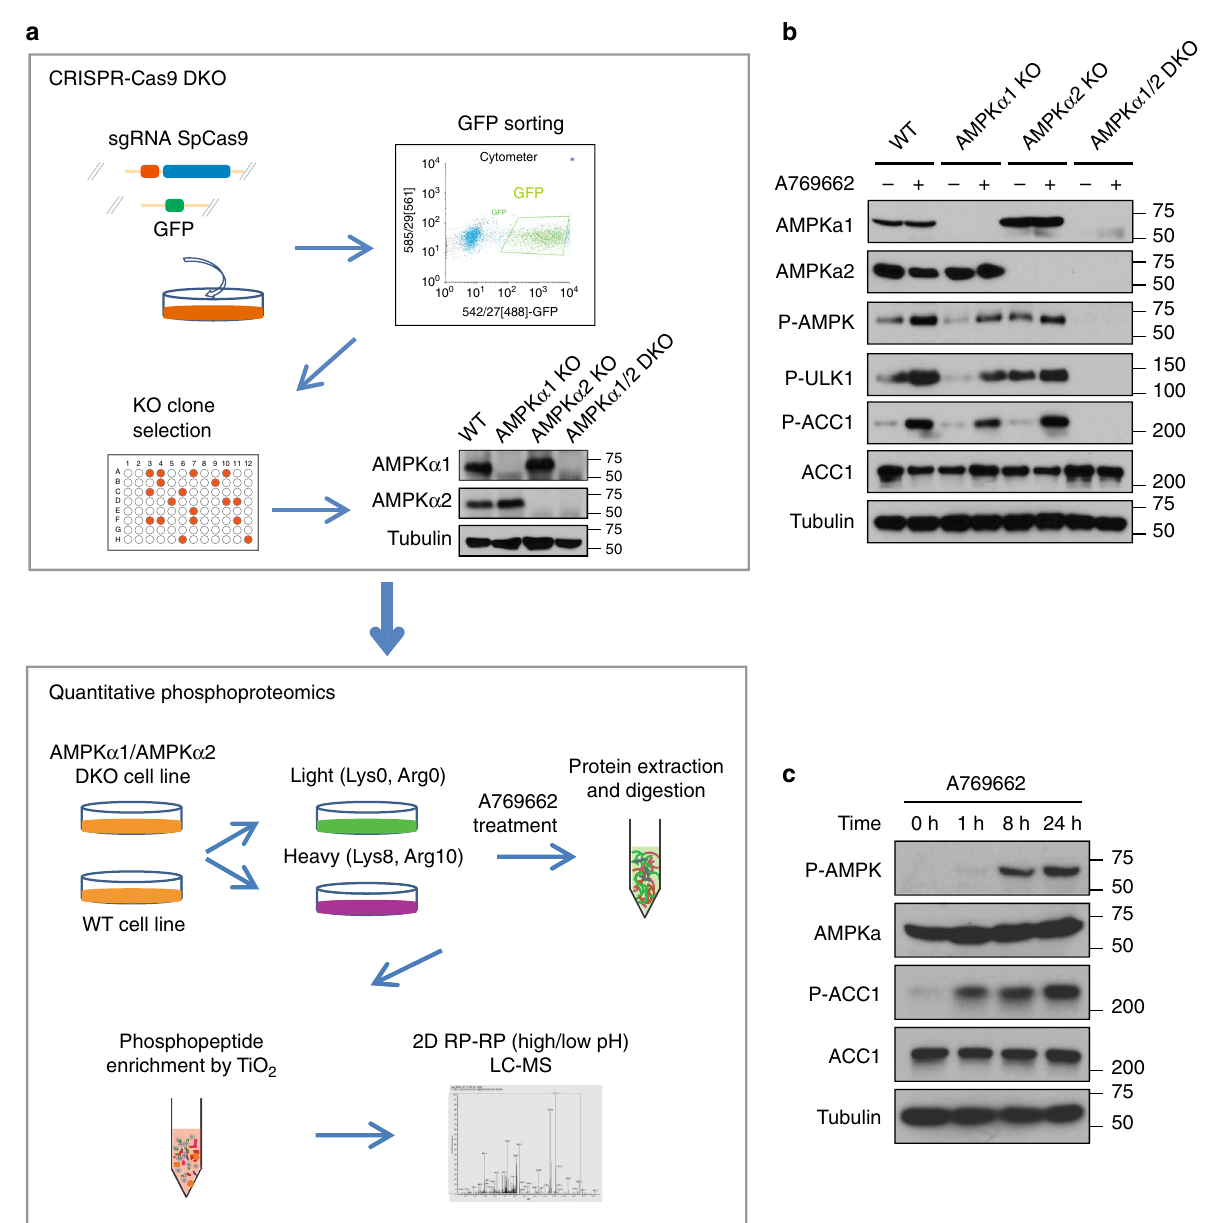
Fig. 1 Phosphoproteomic screening to identify AMPK substrates. a The phosphoproteomics work fl ow. AMPK α 1/ α 2 – double knockout (DKO) HEK293A- derived cells were generated using the CRISPR-Cas9 genome-editing technology. These cells were used as controls to compare with parental (WT)